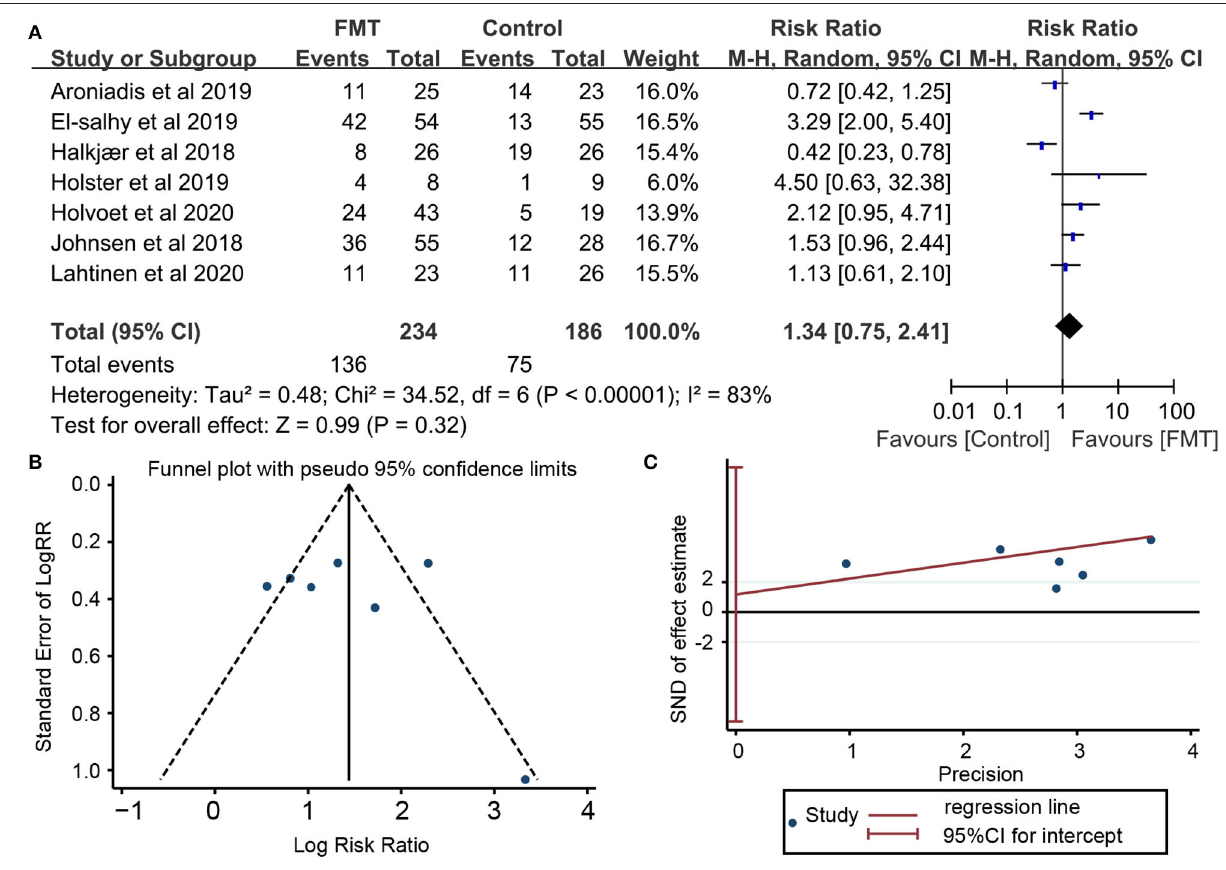
FIGURE 3 | Forest plot and publication bias for the effect of FMT on the primary outcome. (A) Forest plot: random-effects meta-analysis of the effect of FMT on the primary outcome of irritable bowel syndrome (IBS) compared with placebo; (B) Funnel plot of global improvement of IBS for publication bias; (C) Egger’s test global improvement of IBS for publication